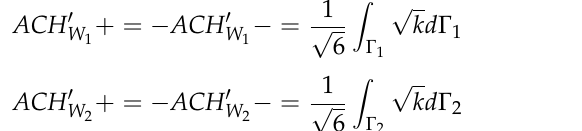
Table 3. Dimensionless air exchange rate ( ACH +/ − ) for cross-ventilation under different Ri cases.